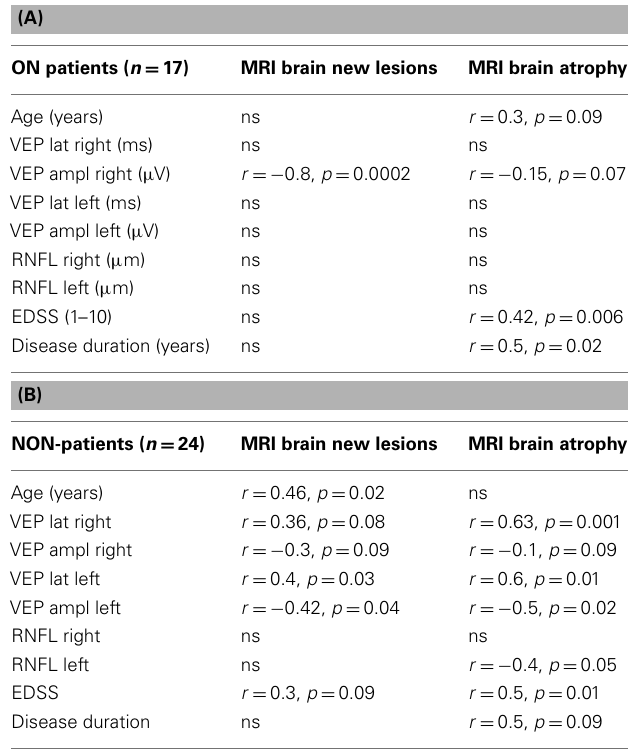
Table 2 | (A) Correlation of MRI with age,VEP, RNFL, EDSS and disease duration ON patients. (B) Correlation of MRI with age,VEP, RNFL, EDSS and disease duration NON-patients